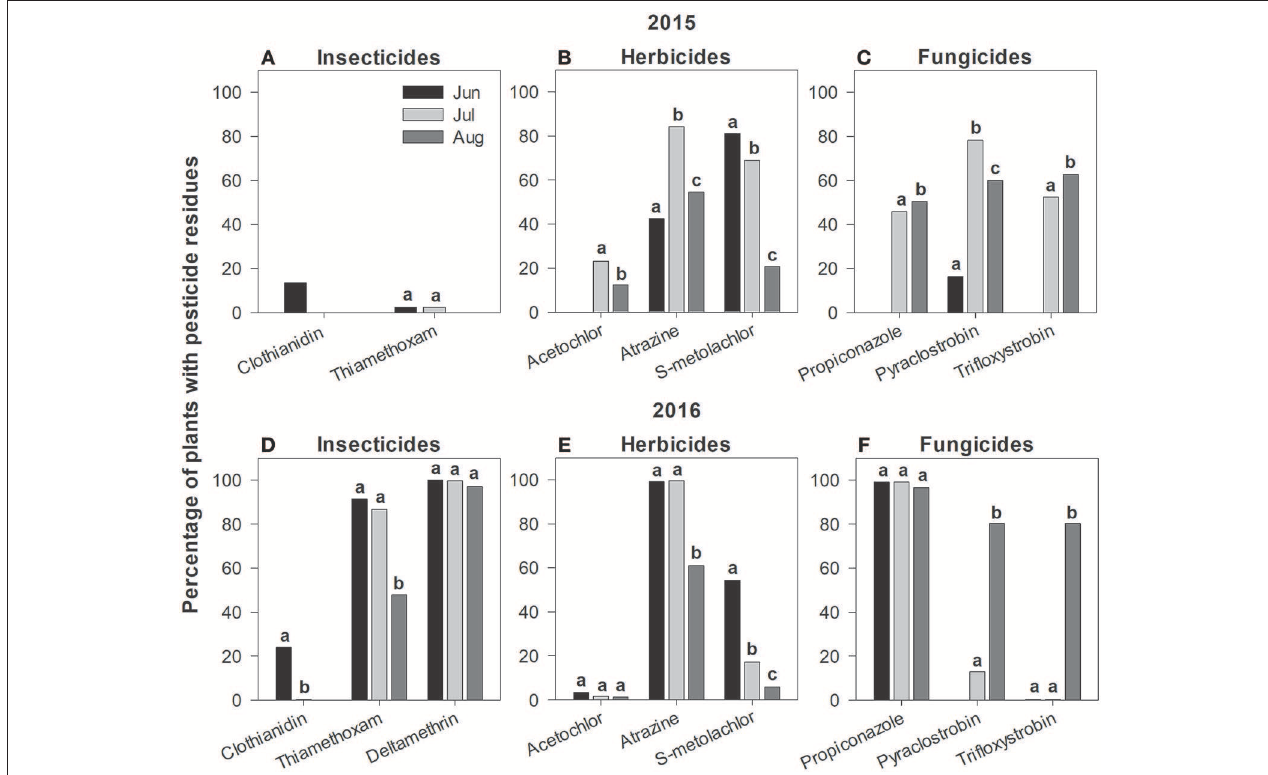
FIGURE 1 | Frequency of pesticide residues detected from milkweed leaf tissue during June, July and August 2015 (A–C) and 2016 (D–F) . Percentages are calculated from samples summed across all study sites. Months with different letters, by pesticide, indicate significant differences ( P < 0.05).